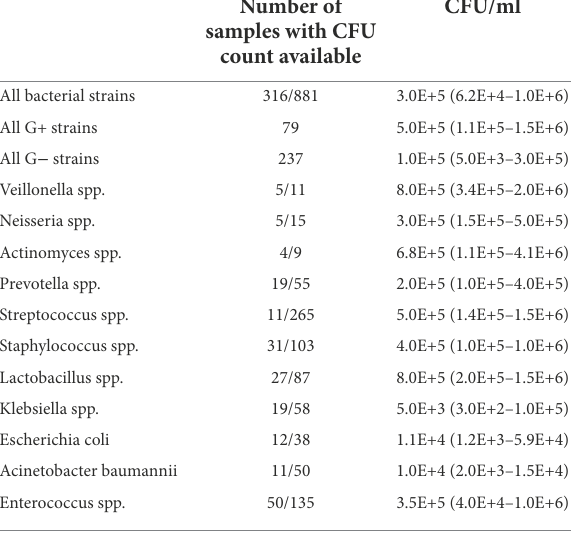
TABLE 3 Baseline quantitative microbiological characteristics of study participants.